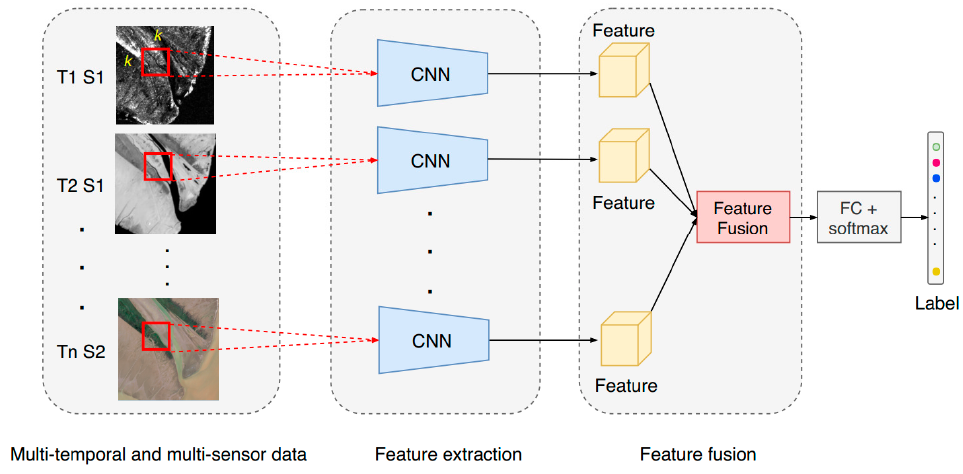
Figure 3. An overview of the proposed multibranch convolutional neural network (CNN).